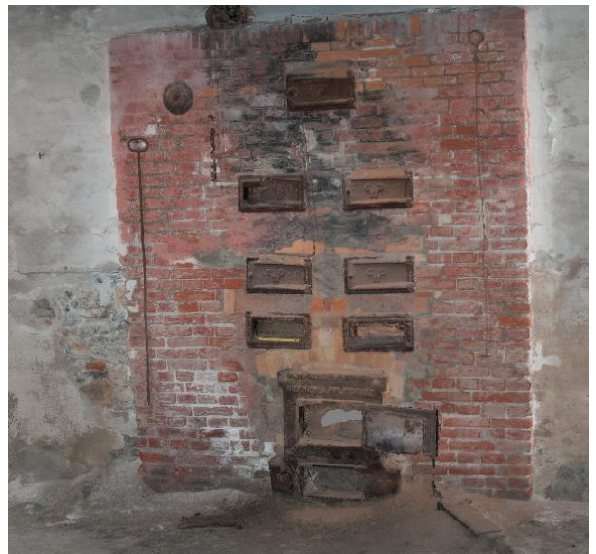
Figure 6. Tiled model view of case C, a wall of the ovens in the kitchen of the Albergo dei Poveri